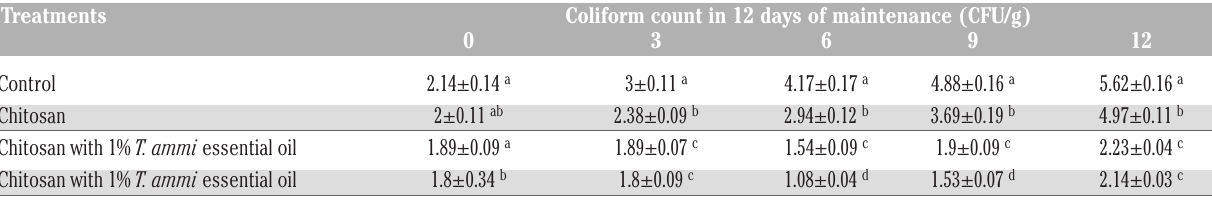
Table 3. Levels of coliform count for various treatments of chicken fillet on maintenance period.